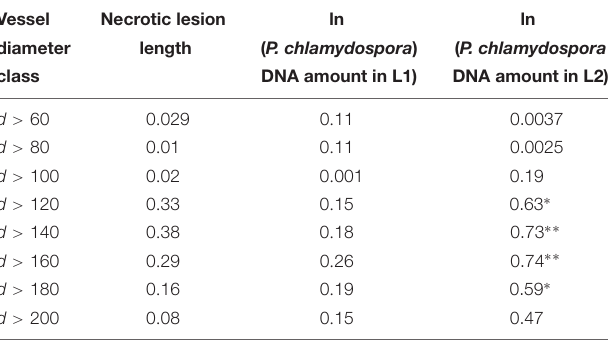
TABLE 2 | Correlation between the degree of resistance of Vitis vinifera cultivars and the density of wide diameter xylem vessels.